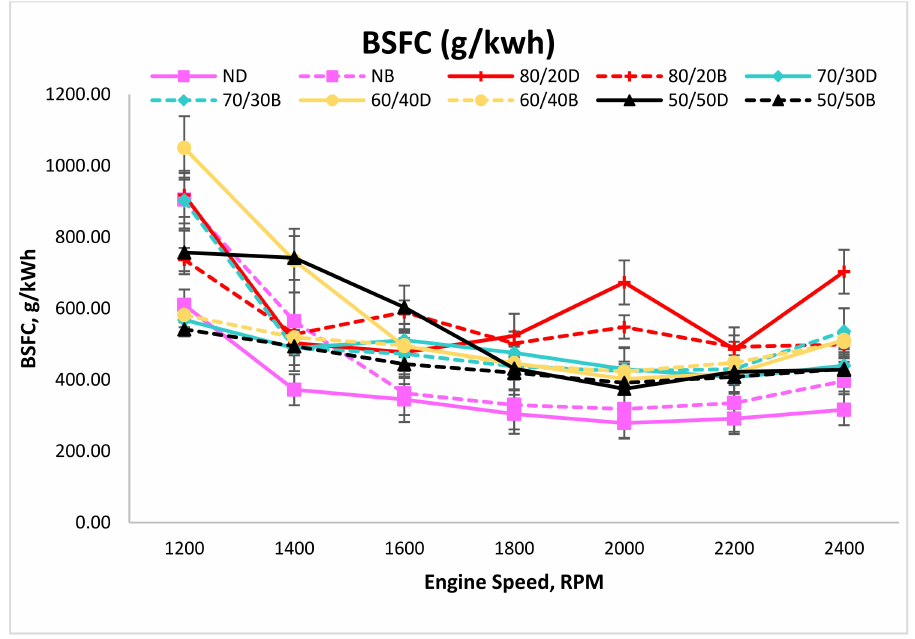
Figure 11. BSFC at various engine